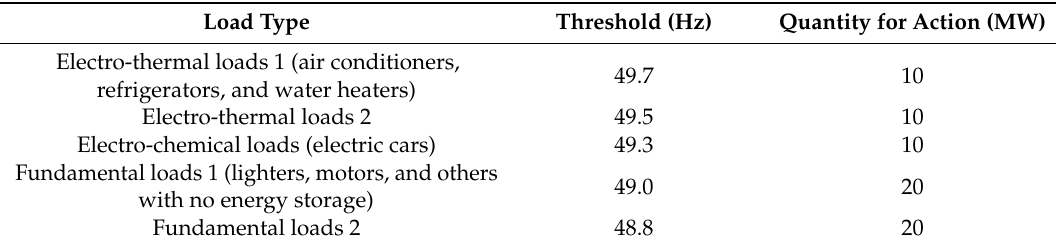
Table 2. Frequency thresholds and quantity of under-frequency load shedding (UFLS) via DR approach.